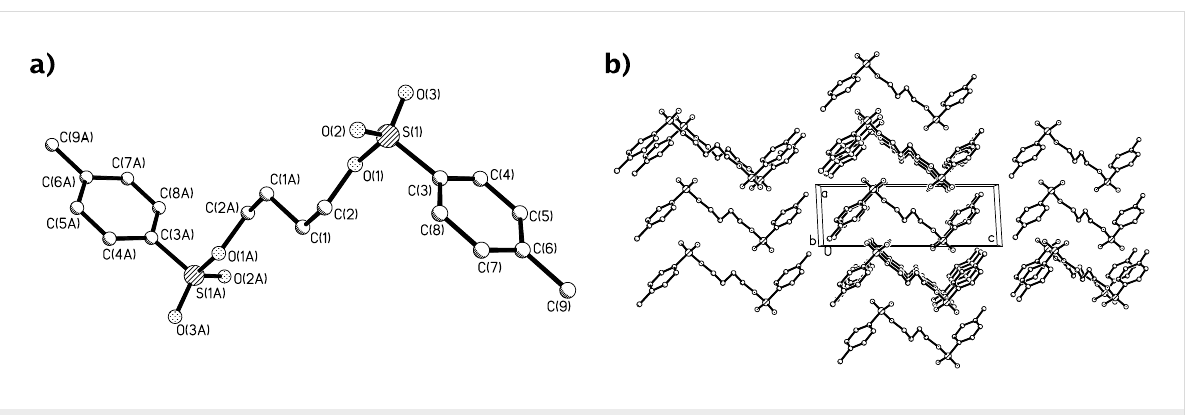
Figure 4: Molecular structure a) and packing diagram b) of the structure of 1,4-butanediol ditosylate